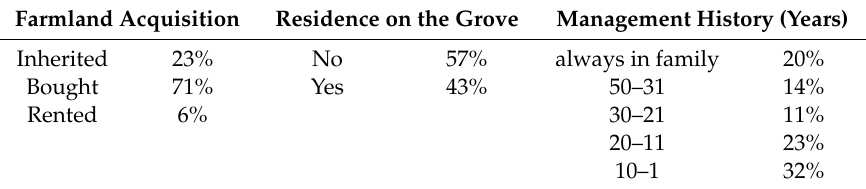
Table 4. Characteristics of the land ownership by the hobby farmer samples ( n = 35); % refers to the total per item.